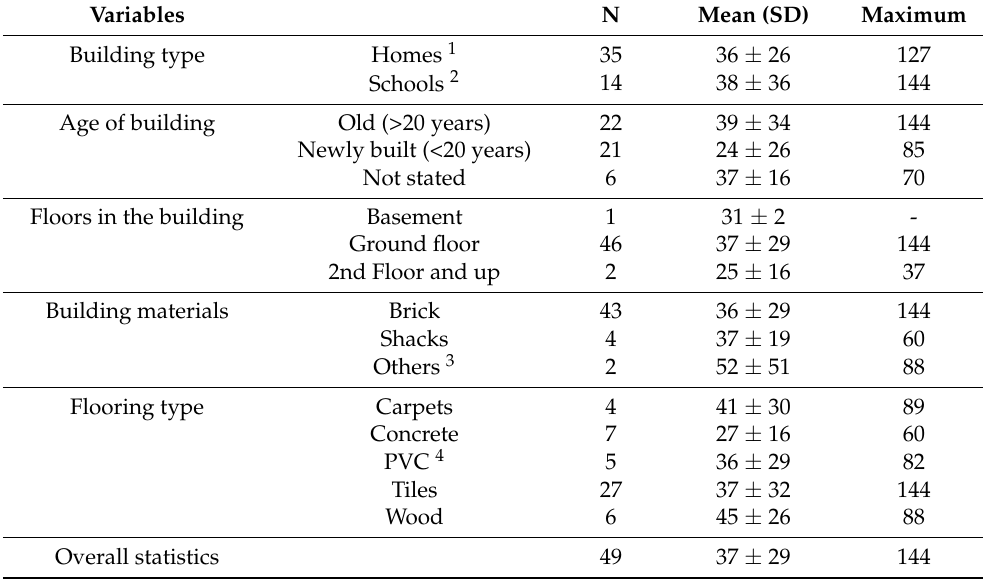
Table 1. Summary of the statistics for measured indoor radon levels (Bqm − 3